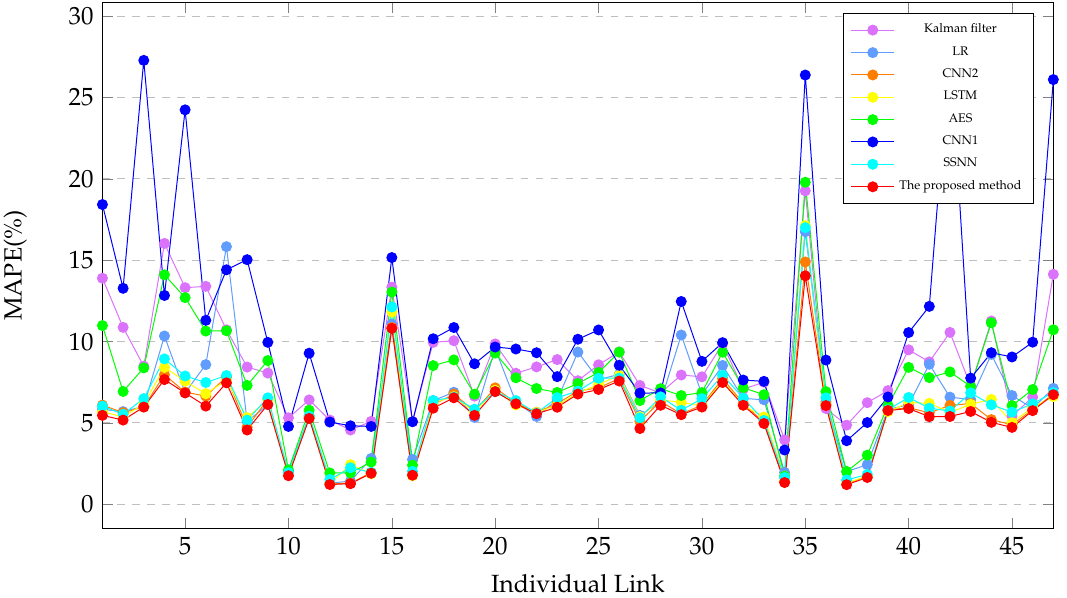
Figure 11. Experimental results of the proposed method and the baseline methods on individual